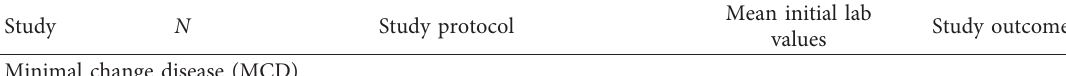
Table 7: Summary of studies on ACTH in minimal change disease.